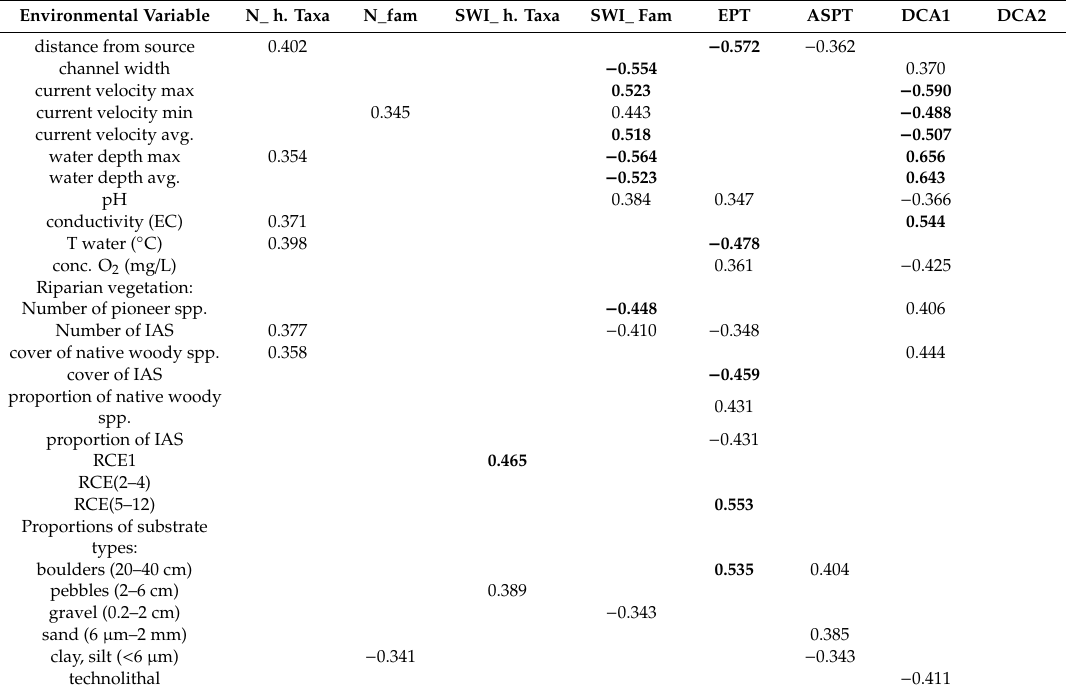
Table 2. Kendall tau correlation coe ffi cients ( τ ) between environmental parameters and structure of macroinvertebrate community. Statistically significant ( p < 0.05) correlations are shown only. Highly significant correlations ( p < 0.01) are in